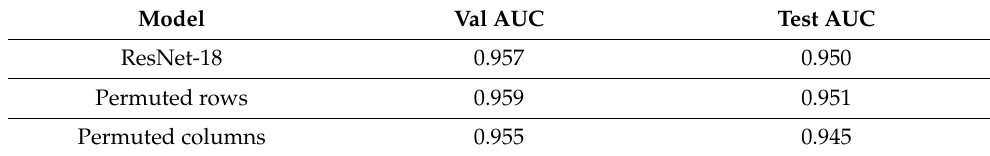
Table 4. Effect of permuting rows and columns of the images on the model performance.